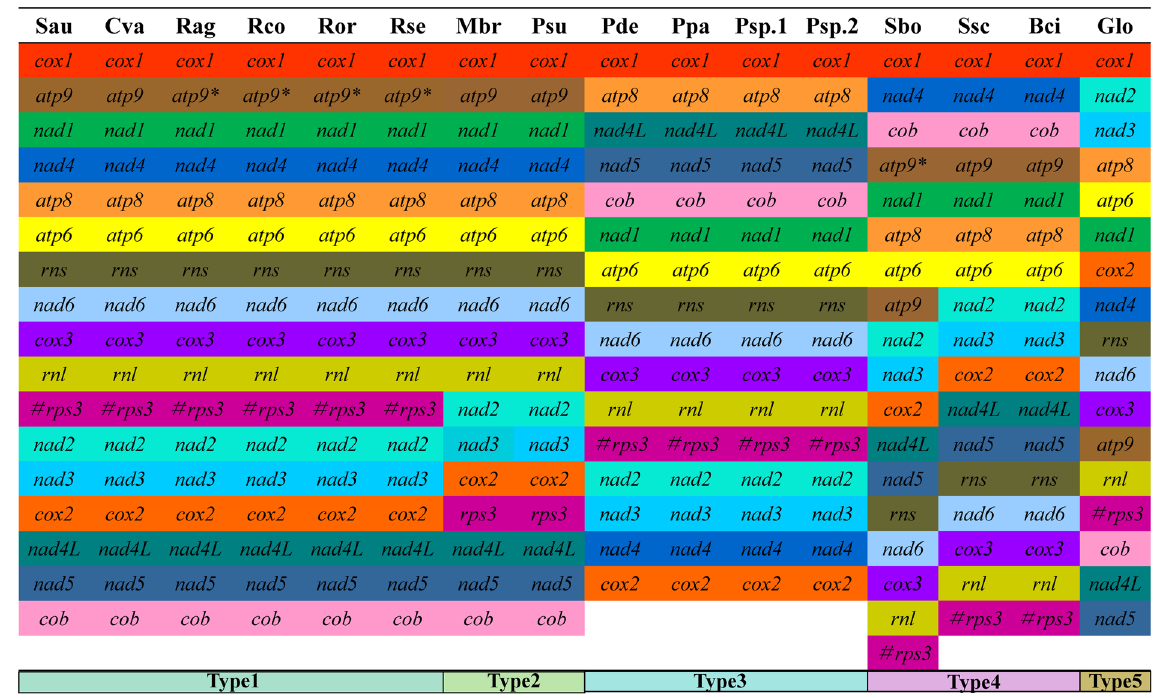
Figure 4. Comparison of gene order across 16 Leotiomycetes mitogenomes. Cva, Cairneyella variabilis (NC_029759); Glo, Glarea lozoyensis (NC_031375); Mbr, Marssonina brunnea f. sp. Multigermtubi (NC_015991); Psu, Phialocephala subalpine (NC_015789); Pde, Pseudogymnoascus destructans (NC_033907); Ppa, Pseudogymnoascus pannorum (NC_027422); Psp1, Pseudogymnoascus _sp._04NY16 (CM004376); Psp2, Pseudogymnoascus _sp._BL308 (CM004375); Rag, Rhynchosporium agropyri (NC_023125); Rco, Rhynchosporium commune (NC_023126); Ror, Rhynchosporium orthosporum (NC_023127); Rse, Rhynchosporium secalis (NC_023128); Sbo, Sclerotinia borealis (NC_025200) ; Ssc, Sclerotinia sclerotiorum 1980 UF-70 (NC_035155); Bci, Botrytis cinerea (Broad Institute); Sau, Scytalidium auriculariicola (MK111108). The # symbol indicates the rps3 gene is located in the intron of the rnl